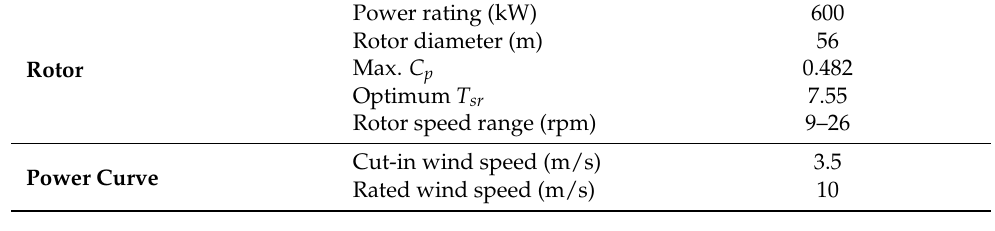
Table 2. Parameters for a 600 kW HTS wind turbine.